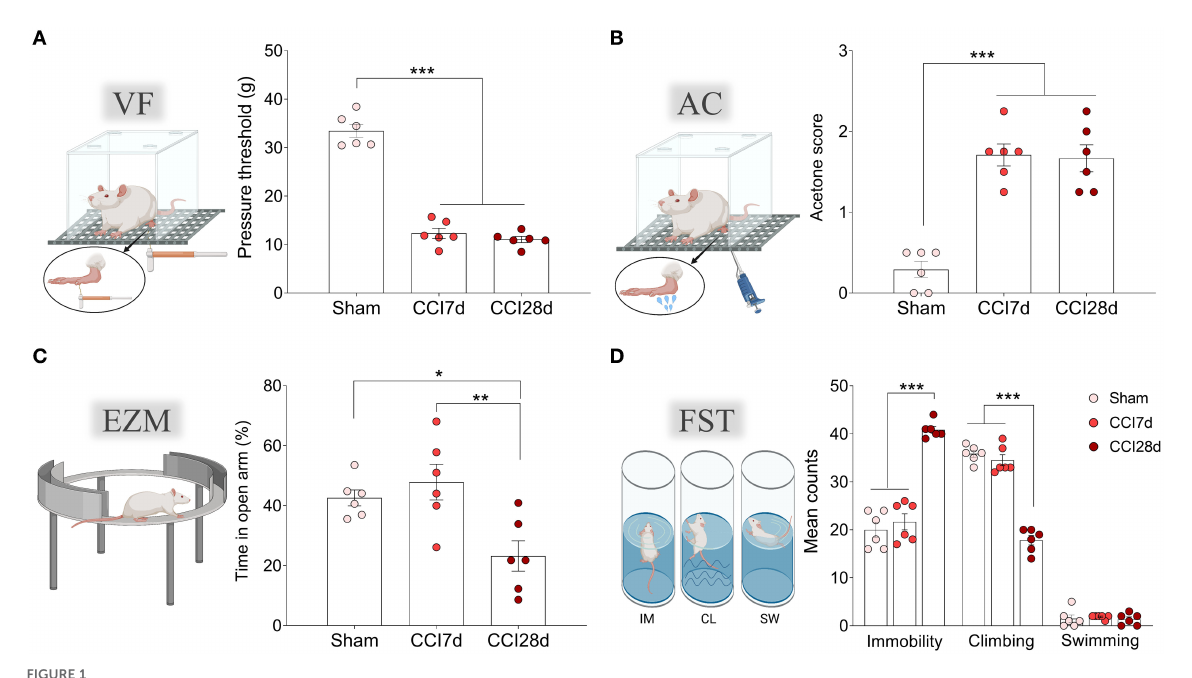
FIGURE1 Nociceptive and emotional behaviors after chronic constriction injury. (A) Mechanical hypersensitivity (g) of the ipsilateral paw in response to von Frey (VF) hair stimulation (0–50g, 20s). (B) Thermal hypersensitivity of the ipsilateral paw in response to acetone (AC) application (100 µ l). (C) Anxiety-related behavior in the elevated zero maze test (EZM) and the relative time spent in the open areas (5min test). (D) Depressive-related behavior in the forced swimming test (FST) relative to the predominant behavior (IM, immobility; CL, climbing; SW, swimming: 5min test). Each bar represents the mean ± SEM of six animals/group: * p < 0.05, ** p < 0.01, *** p < 0.001 as assessed by one-way ANOVA followed by Tukey’s post-test.